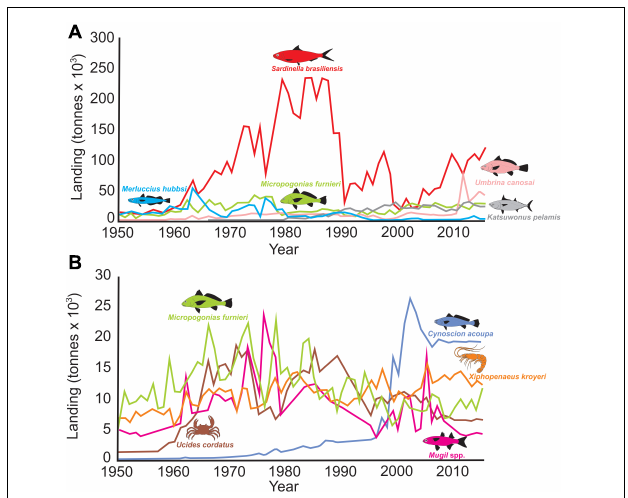
FIGURE 5 | Landing for the top five species in tonnage caught by industrial (A) and artisanal (B) fisheries in Brazil (1950–2015). Note the different Y -scales used for industrial and artisanal fisheries.